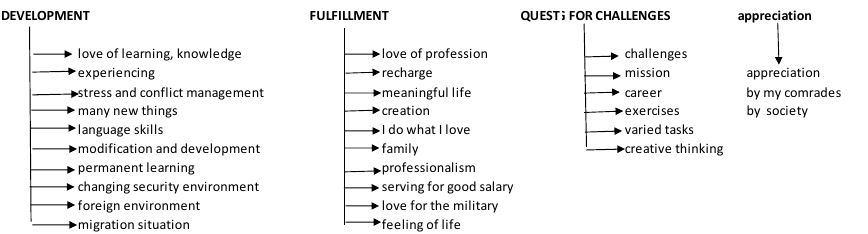
Figure 3. Selective codes and the terms belonging to them.